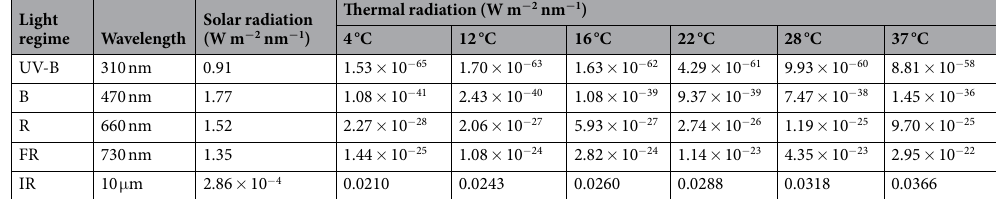
Table 1. Thermal spectral irradiance at plant physiological wavelengths. Plants efficiently sense UV-B, blue (B), red (R), and far-red (FR) lights using distinct photoreceptors. They are also responsive to IR thermal radiation. Spectral irradiance was calculated at the specific wavelengths. The wavelength of IR was set to 10 μ m, around which the spectral irradiance of thermal radiation was maximal in Fig.